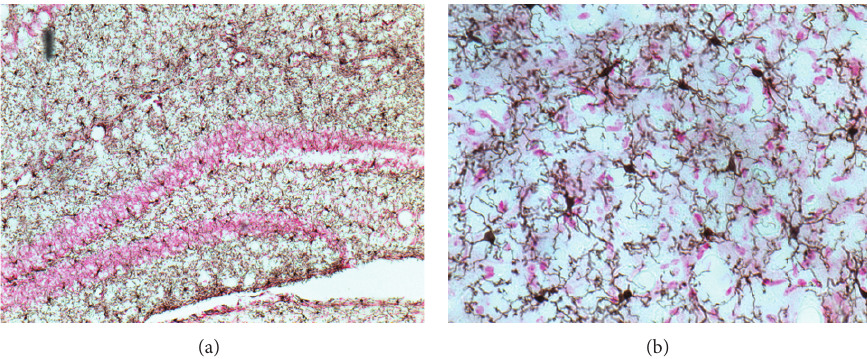
Figure 1: (a) Distribution of Iba1+ microglial cells in the mouse hippocampus. Total cells are stained with fast red. (b) High magnification of microglial staining in the striatum, showing cell bodies and